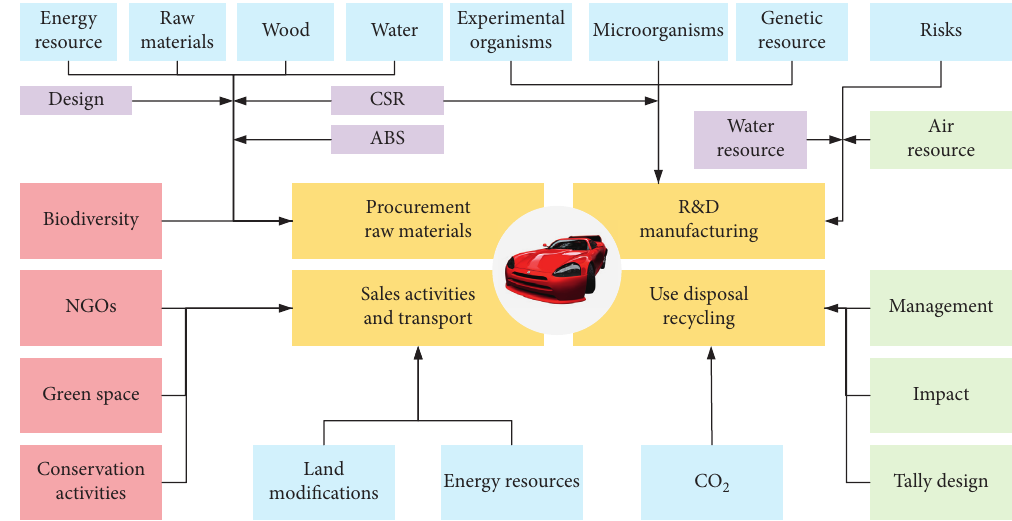
Figure 1: Relationship between environmental and social